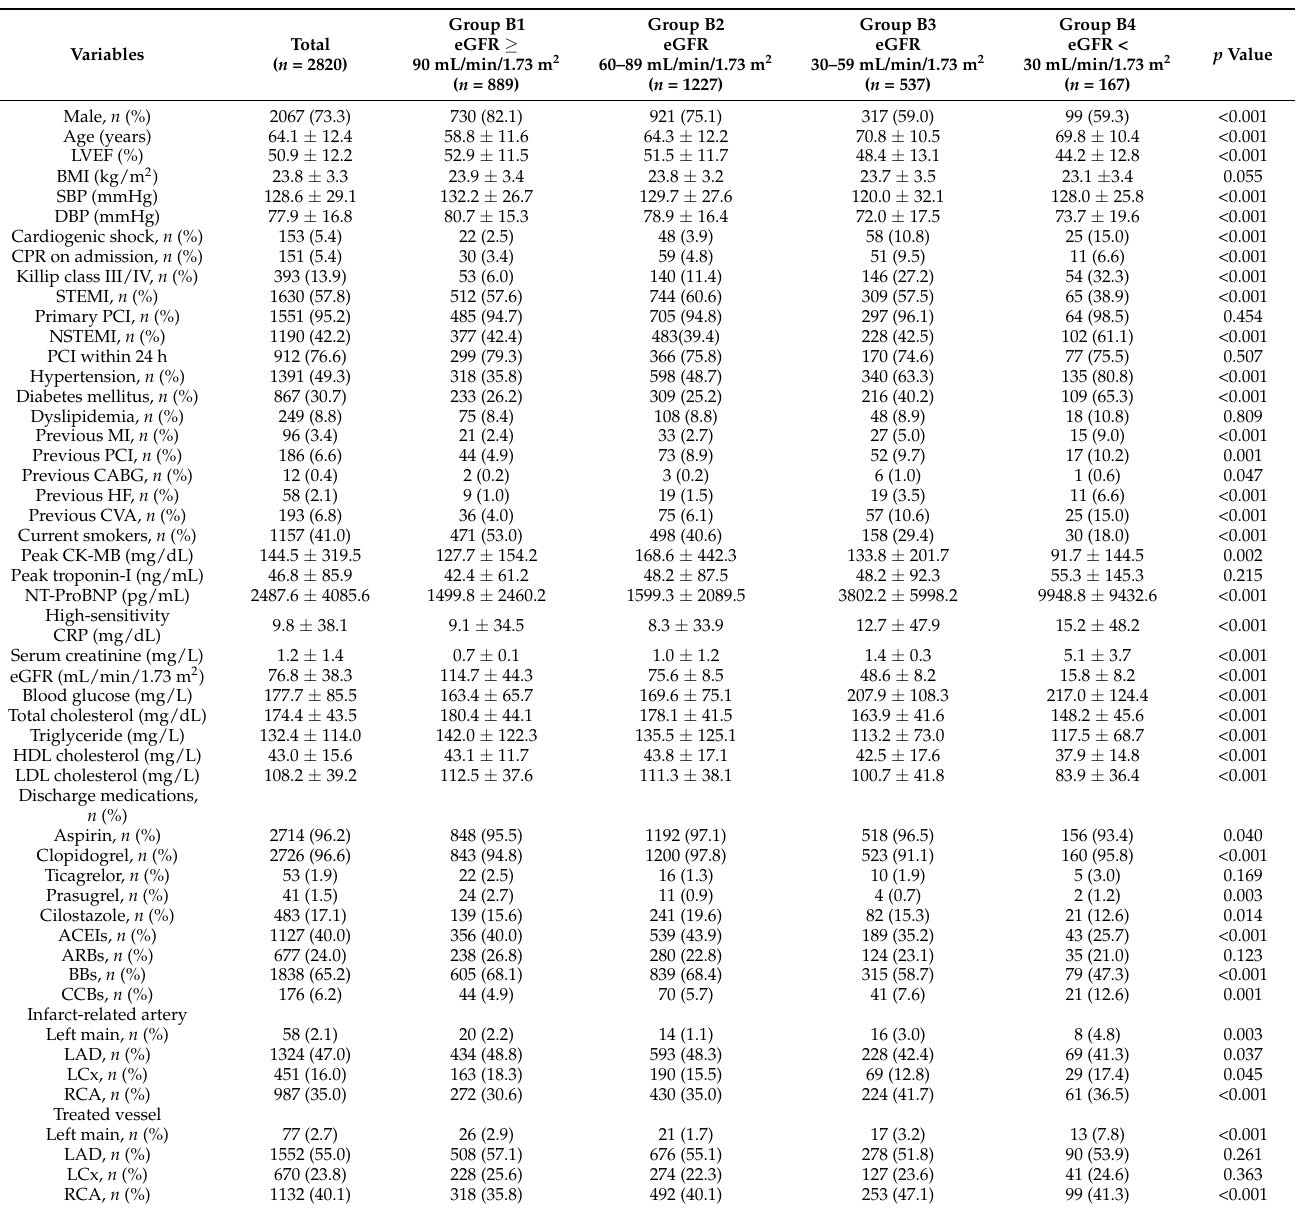
Table 2. Baseline characteristics in statin